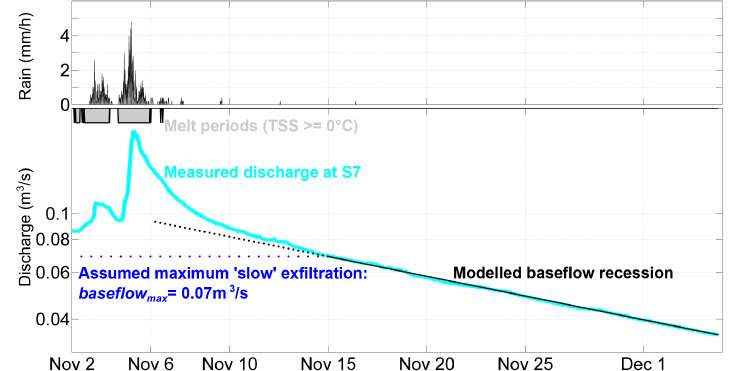
Figure 2. Baseflow recession during November 2008. The lower panel shows measured and modelled discharge at S7 on a logarithmic scale. The dotted black line illustrates how the modelled baseflow recession diverges from measured discharge before 15 November. Note that melting periods (non-negative temperature of snow surface) are indicated as grey shaded bars. The upper panel plots successive rain